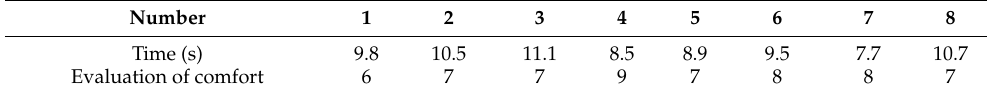
Table 3. Data of Experiment 1 (Key control).